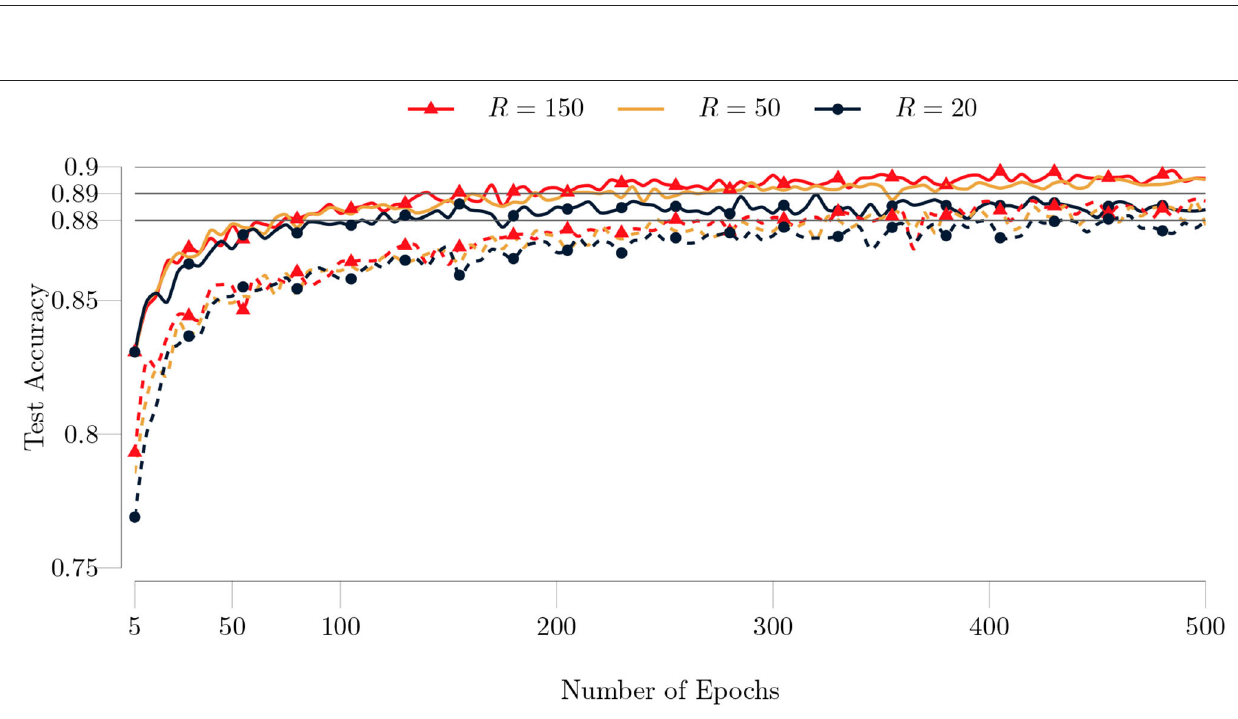
FIGURE 12 | Comparison of test accuracies of the type I model on the Fashion MNIST dataset for different maximum number of GN iterations as a function of the number of epochs. The full training set (60,000 images) and test set (10,000 images) are used. The batch size is set to 100 and the maximum number of GN iterations is set to 1 (dashed lines) and to 5 (solid